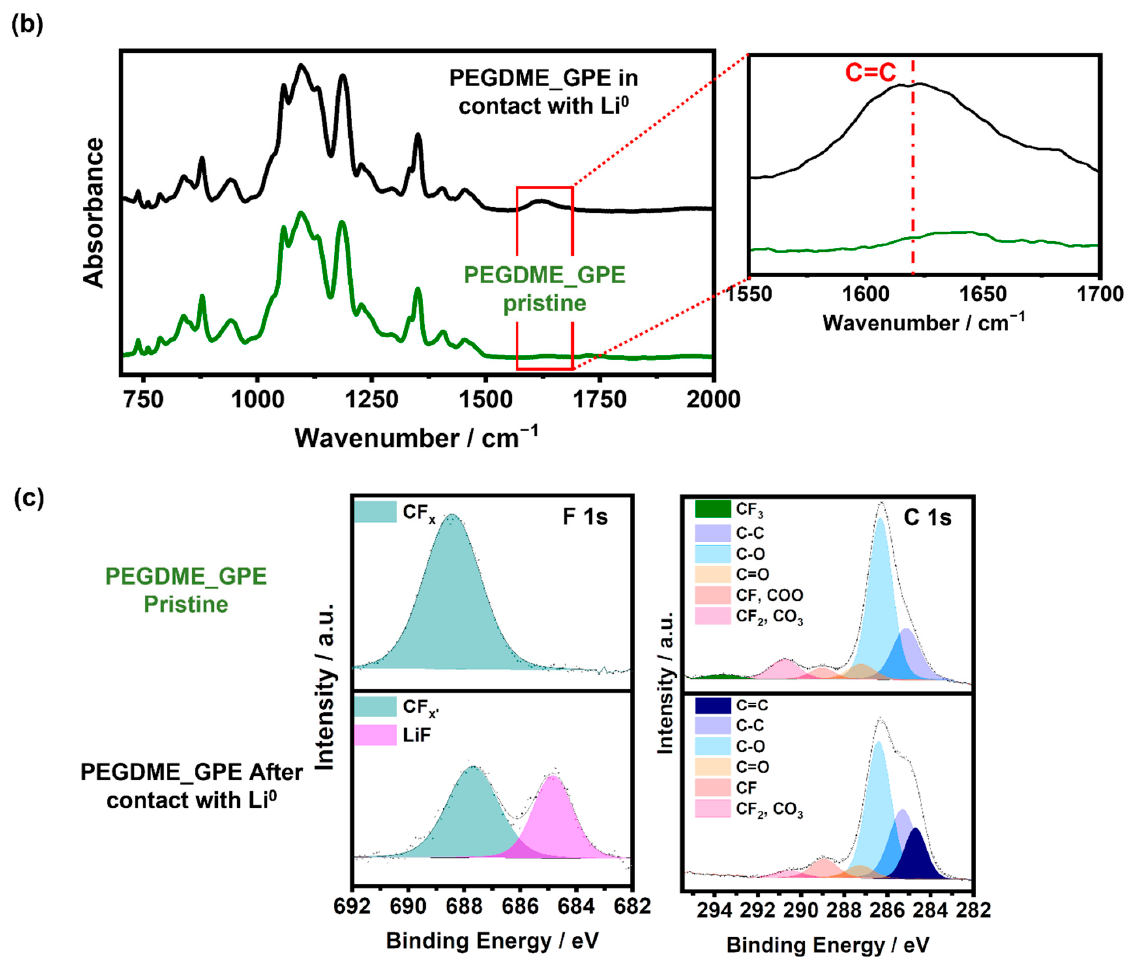
Figure 1. ( a ) Aging test of PEGDME_GPE in contact with Li 0 anode. ( b ) ATR-FTIR spectra of the PEGDME_GPE-based electrolyte before and after being in contact with Li 0 anode. ( c ) F 1s and C 1s regions corresponding XPS of the pristine PEGDME_GPE membrane and PEGDME_GPE after contact with Li 0 anode.